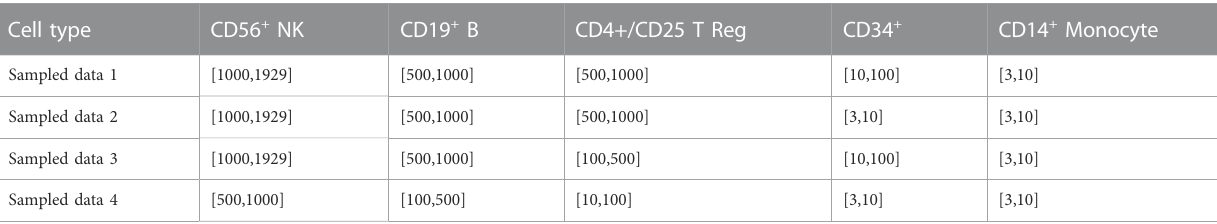
TABLE 2 Sampling range of different cell types for each sampled data.